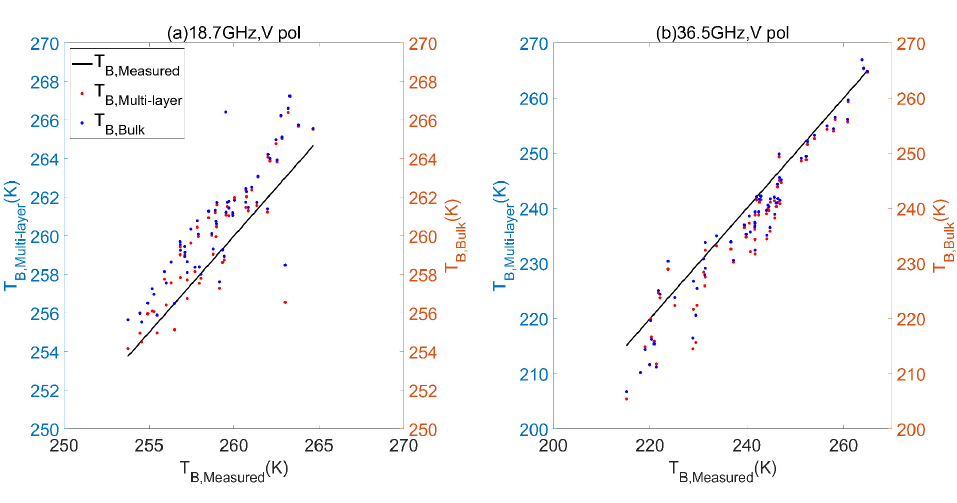
Figure 17. Comparison of the MEMLS-simulated multiple-layer brightness temperature (T B, Multi-layer ) and MEMLS-simu- lated single-layer brightness temperature (T B,Bulk ) to measured brightness temperature (T B,Measured ) at vertical polarization: ( a ) 18.7 GHz; and ( b ) 36.5